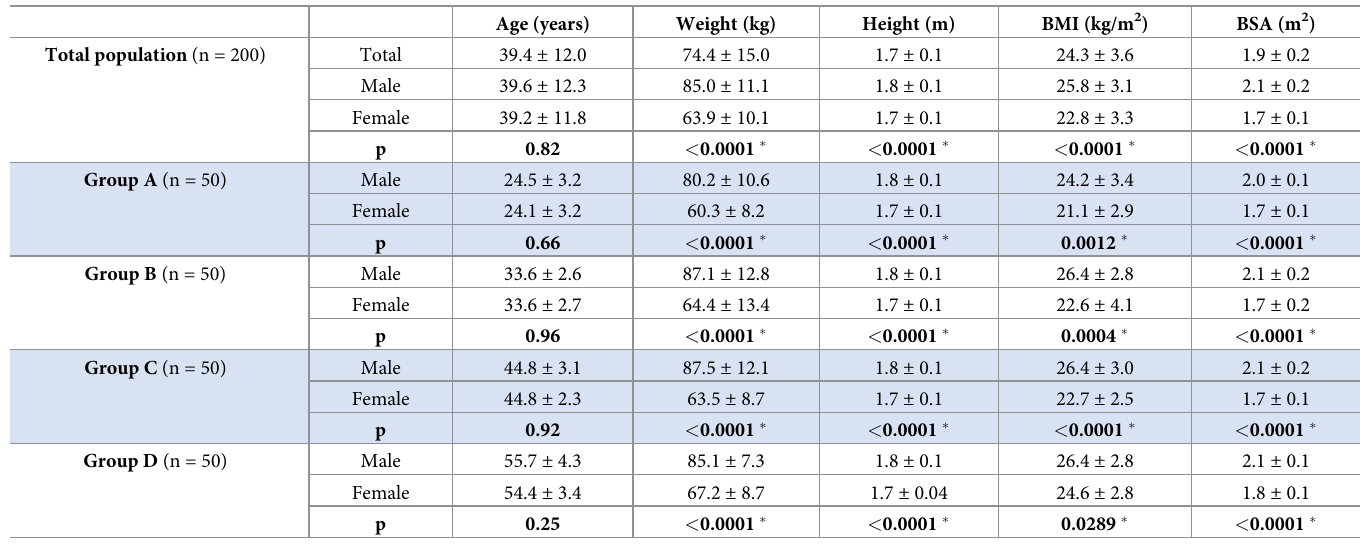
Table 1. Baseline characteristics of the total population and the